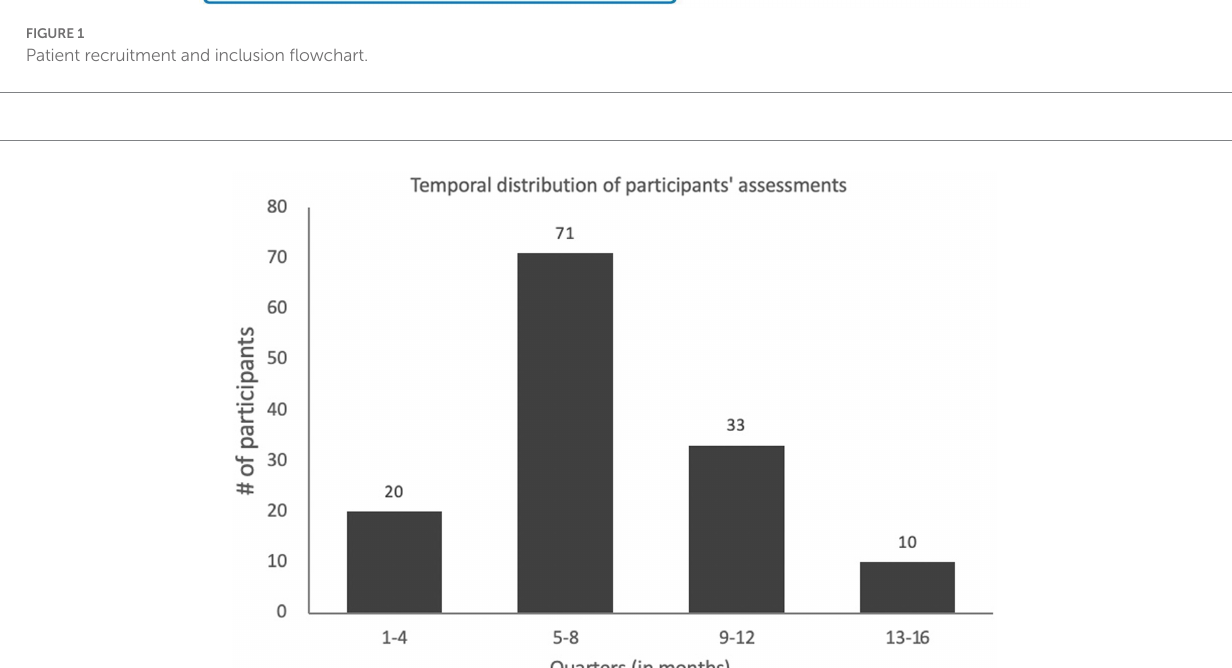
FIGURE 2 Temporal distribution of the participant’s neuropsychological assessments. 20 patients had their assessment 1-4 months, 71 between 5-8 months, 33 between 9-12 months and 10 patients between 13-16 months following their respective COVID-19 infection